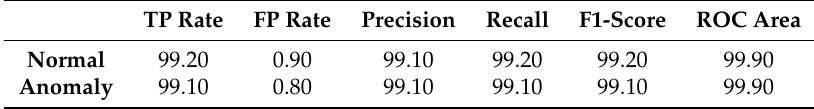
Table 36. Classification report for Bagging Random